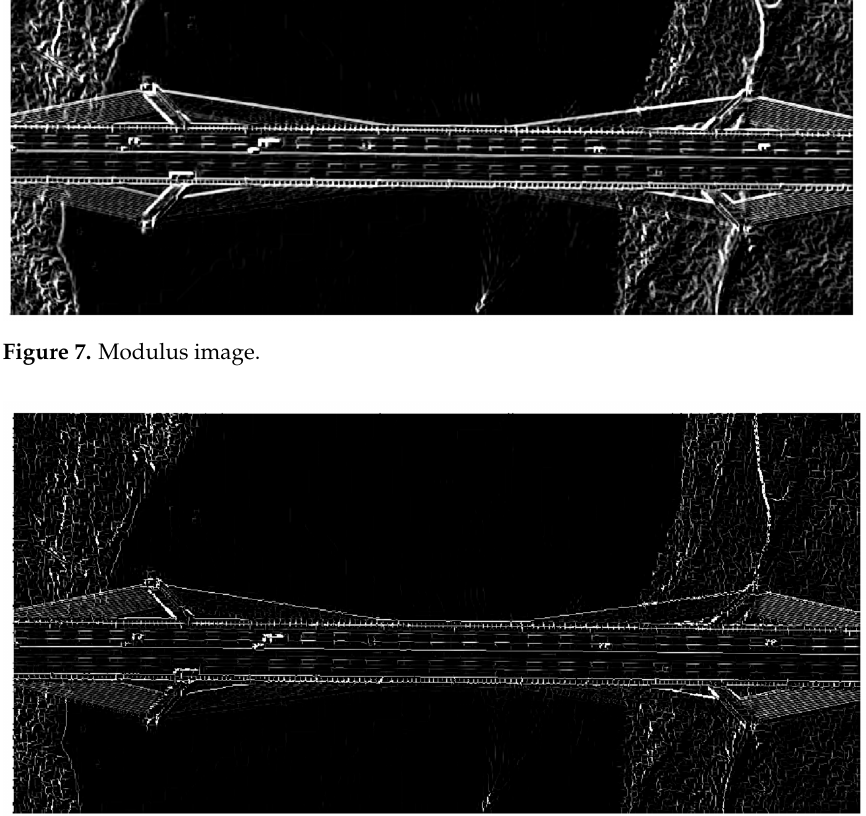
Figure 8. Modulus maximum